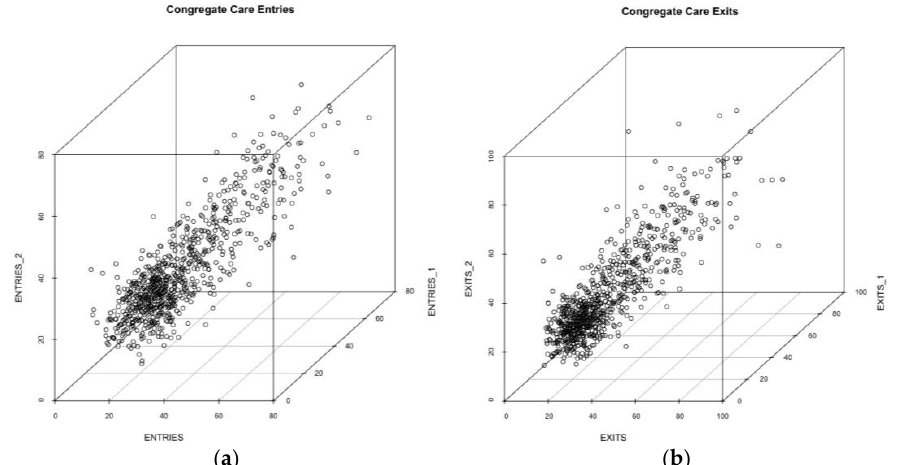
Figure 3. Three-dimensional lag plot of the observed entries ( a ) and exits ( b ) to congregate Care, 2000 to 2015, in their state at time zero (x-axis) compared to the variable position in the first-order lag (y-axis) and second-order lag (z-axis).